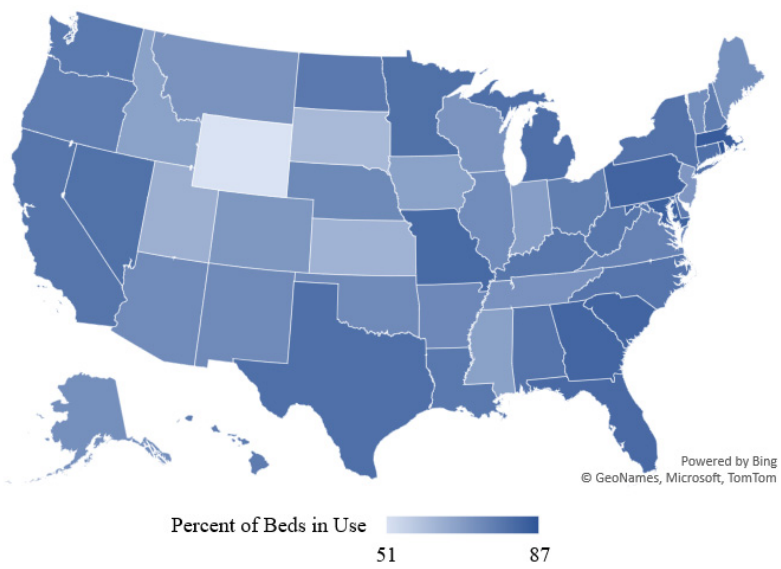
Figure 3. Statewide Bed Utilization, September 2021. Source: (COVID-19 Reported Patient Impact and Hospital Capacity by State Timeseries 2021). Table 1. Descriptive Statistics, Observations by State and